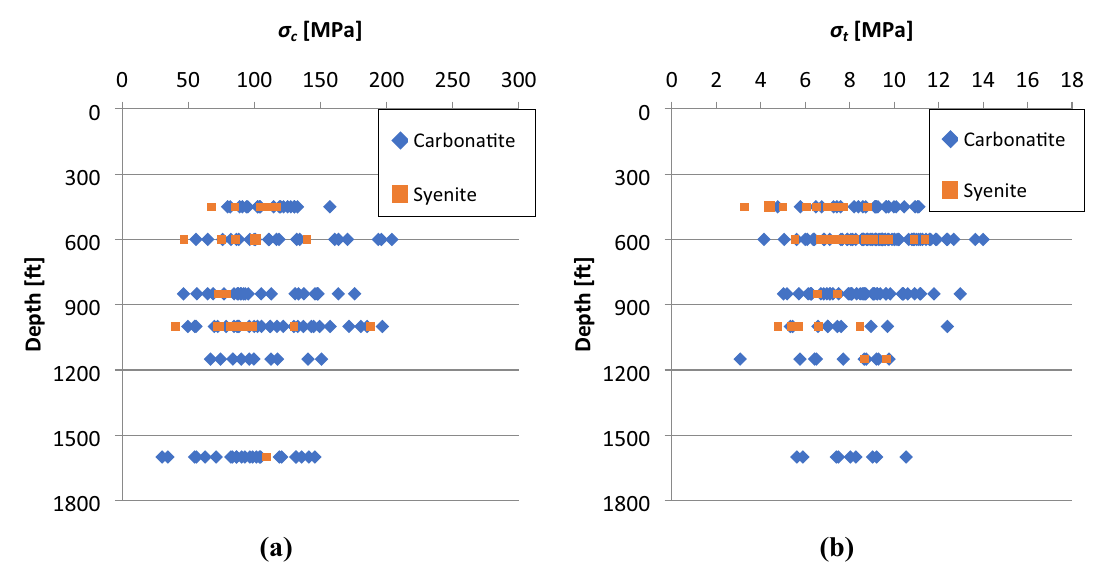
Fig. 3 Distribution of the results as a function of depth for a Young’s Modulus and b Poisson’s ratio